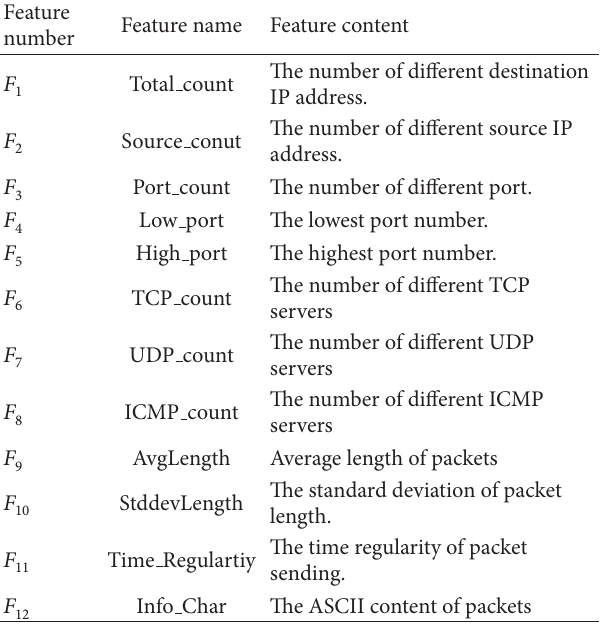
Table 1: Features of the botnet